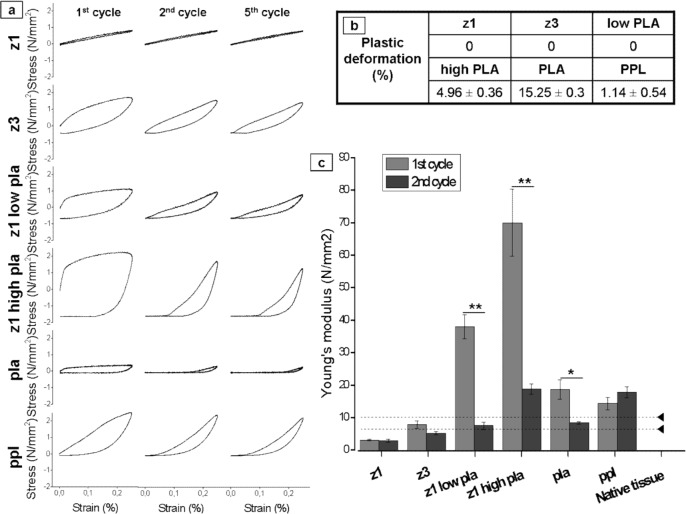
Cyclic uniaxial tensile test of the different materials.(a) Strain-stress plots of the 1st, 2nd and 5th cycle. (b) Plastic deformation (%) at the 2nd cycle. (c) Young’s modulus of the 1st and 2nd cycle (n-3±SEM), *p<0.05, **p<0.01.